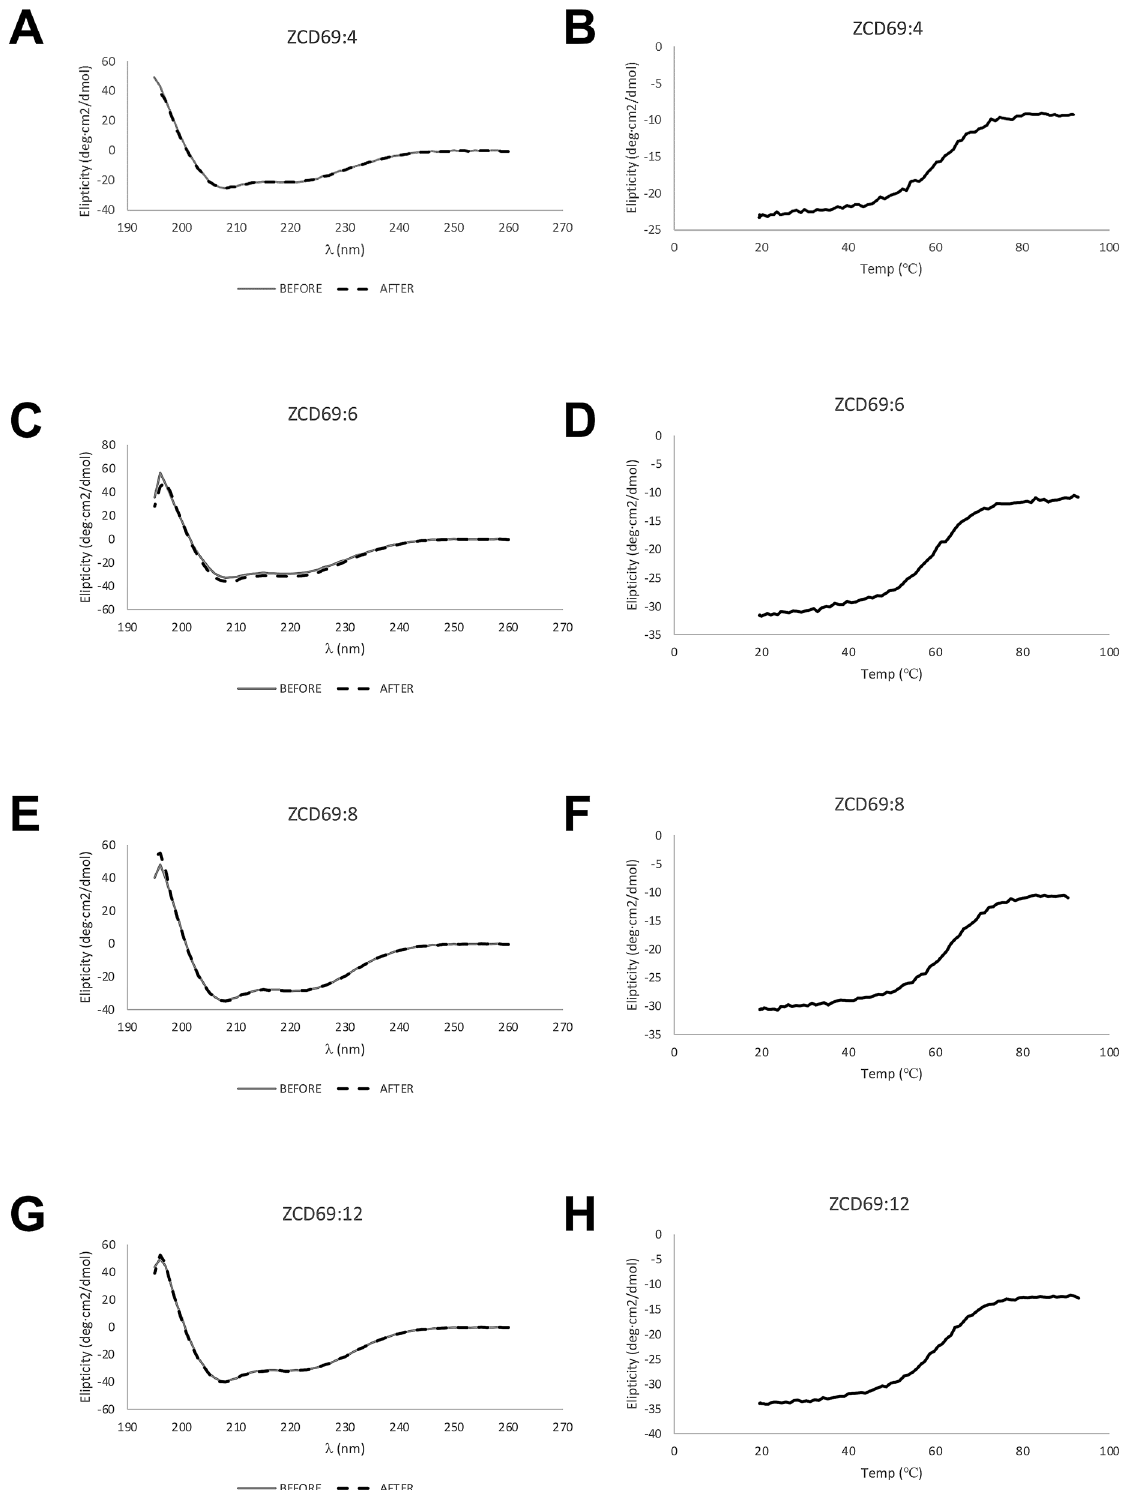
Figure 4. ( A , C , E , G ) Circular dichroism spectrum of affinity maturated Affibody molecules H 6 -Z CD69:X at 20 °C before and after heat-induced denaturation, as well as ( B , D , F , H ) the result of thermal stability analysis of affinity maturated Affibody molecules H 6 -Z CD69:X using circular dichroism